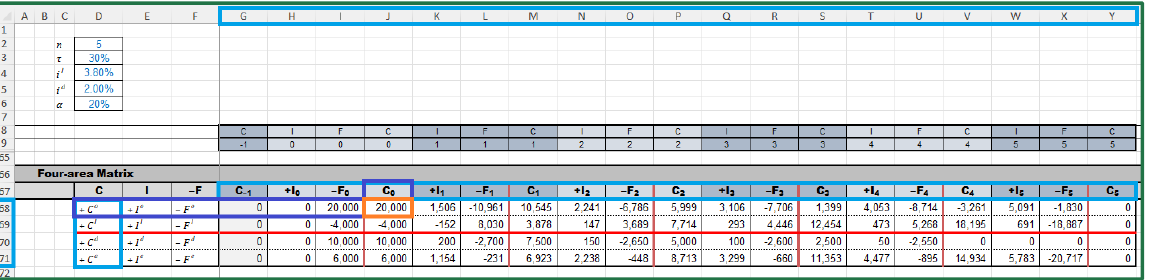
Figure 42. Cell J68 contains the value that has the same row-label as TransMatrix!D6 ( +𝐶 (cid:2868) ) and the same column-label as TransMatrix!I4 ( 𝐶 (cid:2868) ) (“SplitScreenStrip” sheet).